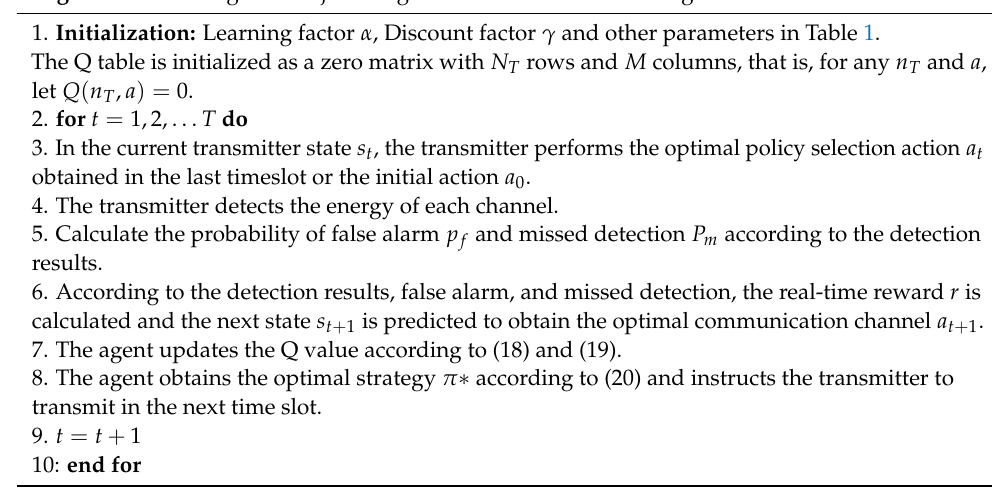
Algorithm 1 is the flow of intelligent anti-jamming communication decision algorithm based on NISS. Algorithm 1: Intelligent anti-jamming communication decision algorithm based on